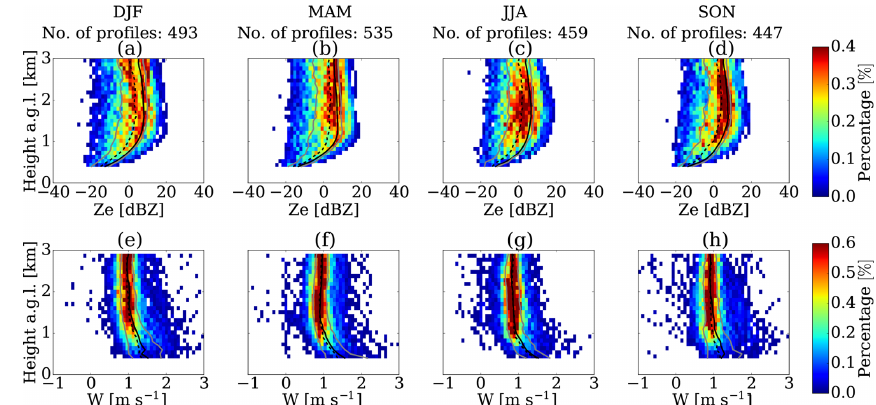
Figure 9. Frequency-by-altitude diagram for Ze (a, b, c) and W (e, f, g) values observed at DDU during DJF (a, e) , MAM (b, f) , JJA (c, g) , and SON (d, h) of virga. Solid black and dashed black lines represent the average and median vertical profiles of Ze and W , respectively. Grey lines correspond to the 20% and 80% quantiles of the vertical profiles.